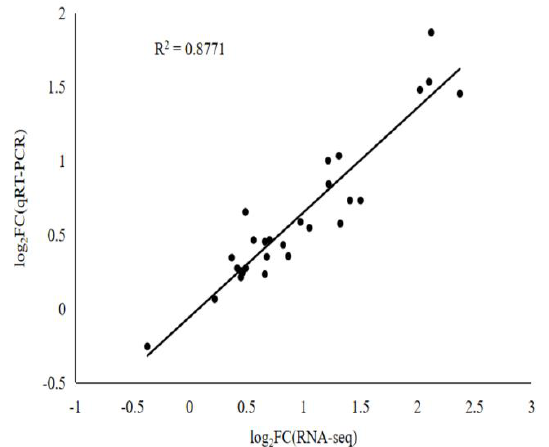
Figure 11. The correlation between the results of RNA-seq and qRT-PCR.